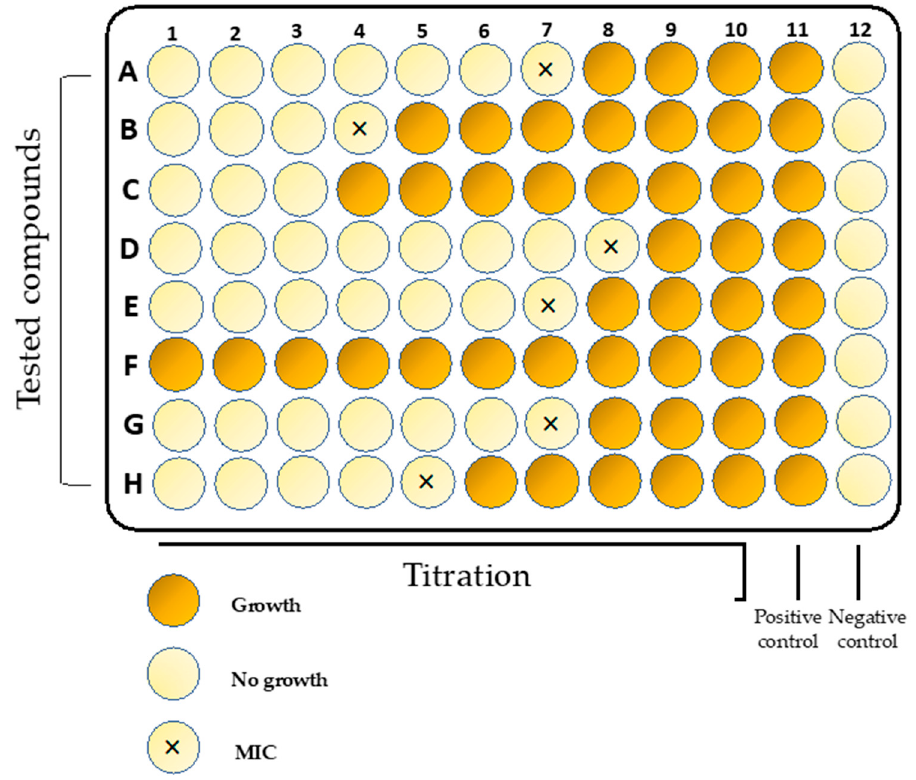
Figure 1. Example of microtiter plate and interpretation of microdilution results. MIC—minimum inhibitory concentration.